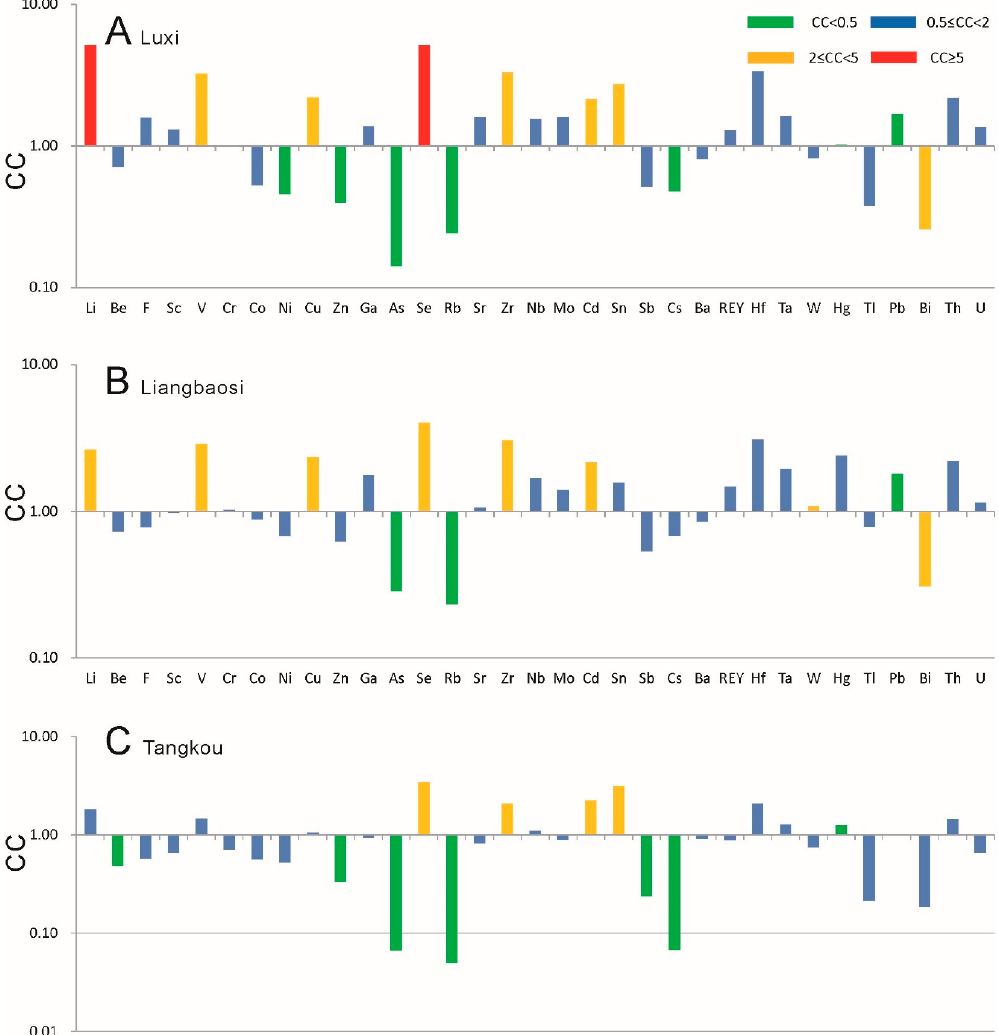
Figure 7. Concentration coefficients (CC) of the trace elements in the three Upper No. 3 coals vs. the world hard coal. Data of world hard coals are from Ketris and Yodovich [35]. ( A ) the Luxi Upper No. 3 coal; ( B ) the Luxi Upper No. 3 coal; ( C ) the Tangkou Upper No. 3 coal.